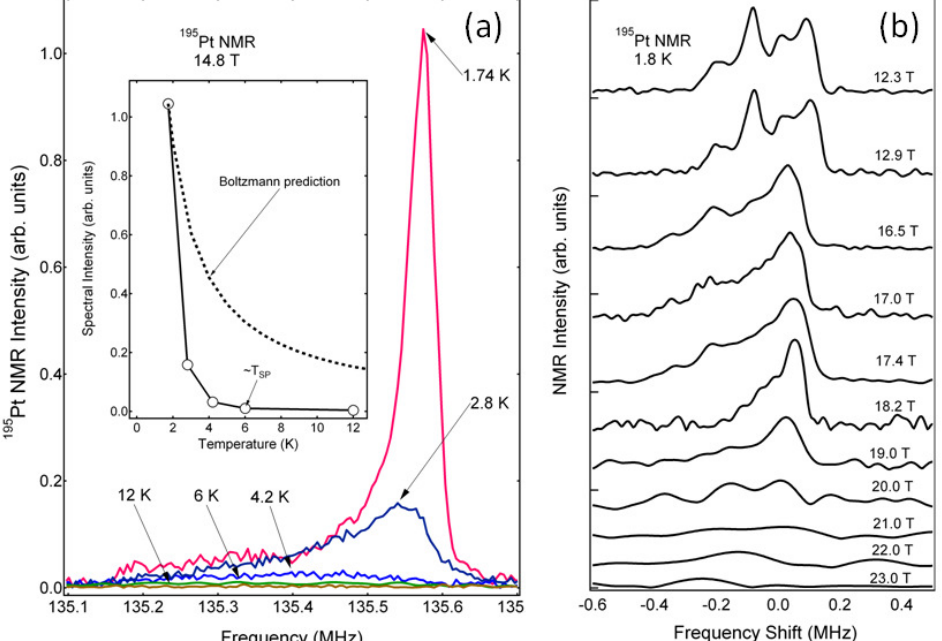
Figure 12. 195 Pt spectra of a Per dependence at 14.8 T. Inset: temperature dependence of peak height compared with the 1/T Boltzmann factor; ( b ) Magnetic field dependence at 1.8 K. Traces are offset for clarity; center frequency = 195 γ